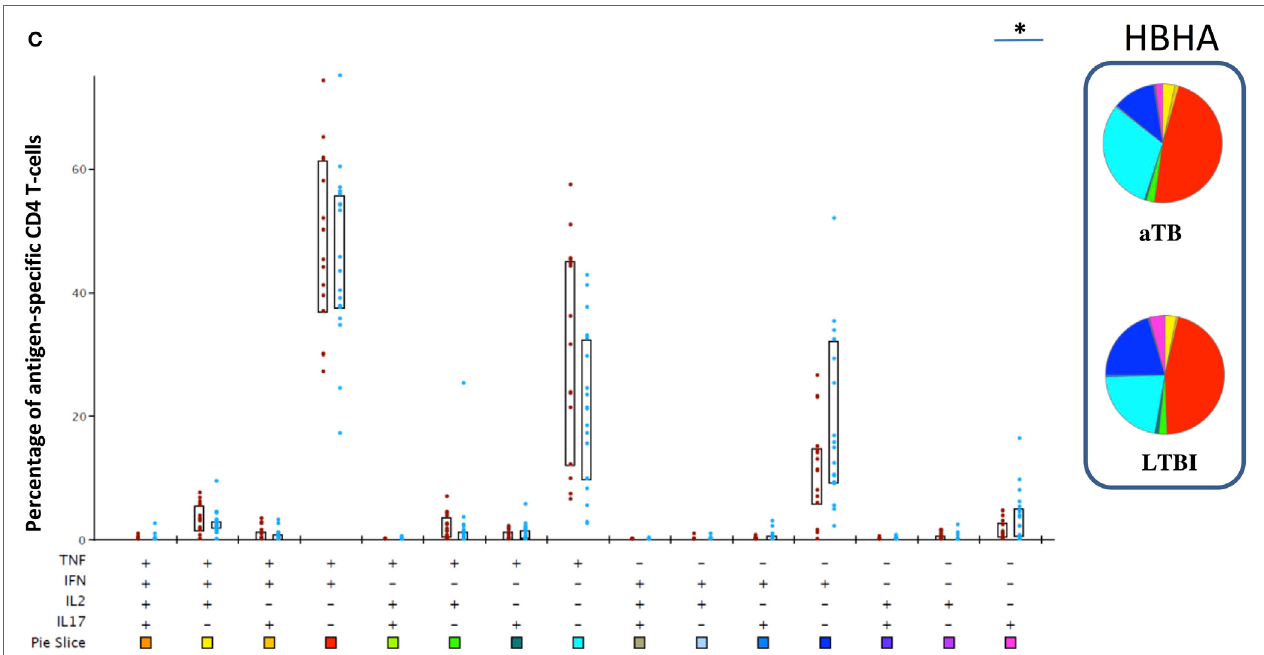
FigUre 3 | Poly-functional profile of Mycobacterium tuberculosis -specific CD4 + T lymphocytes after in vitro stimulation with purified protein derivative (PPD), early-secreted-antigenic target-6 (ESAT-6), or heparin-binding hemagglutinin (HBHA). Peripheral blood mononuclear cell were in vitro stimulated during 5 days with PPD (a) , ESAT-6 (b) , or HBHA (c) and the percentages of all possible combinations of the four studied cytokines (IFN- γ , TNF- α , IL-2, and IL-17) were analyzed among the M. tuberculosis -specific cytokine-containing CD4 + T lymphocytes. Children with active TB (aTB) are represented by the red dots, whereas latently TB infected (LTBI) children are represented by the blue dots. All the possible combinations of cytokines are represented on the x -axis of the bar charts graphs, and color coded, whereas the percentages of each subpopulation within M. tuberculosis -specific CD4 + T cells are shown on the y -axis. Boxes represent interquartile ranges (P25–75). Results were analyzed with SPICE and degrees of significance are based on the “unequal variance T -test.” * p < 0.05; *** p = 0.001. The pie charts average the data for both groups (aTB and LTBI), each slice corresponding to the proportion of M. tuberculosis -specific CD4 + T cells positive for a certain combination of cytokines. The colors in the pie chart are defined by the 15 color boxes on the x -axis of the bar